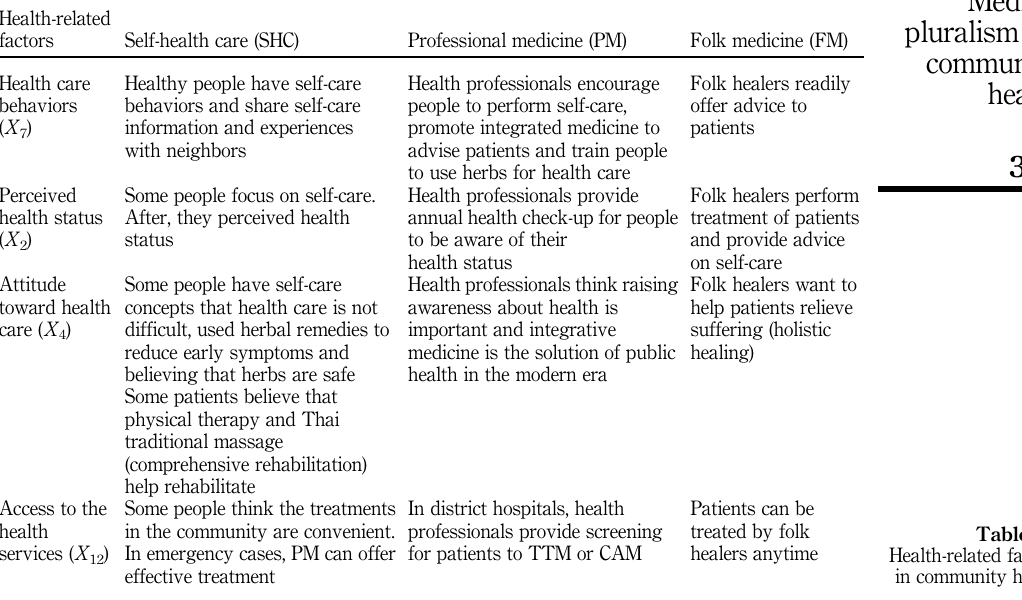
Table IV. Health-related